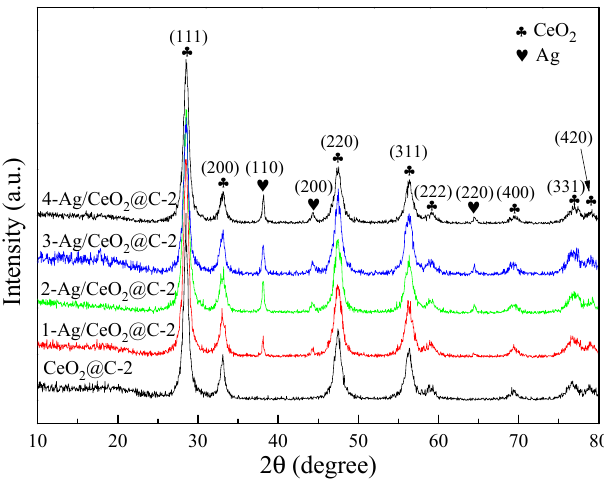
Figure 1. XRD patterns of CeO 2 @C-2 and Ag/CeO 2 @C-2.